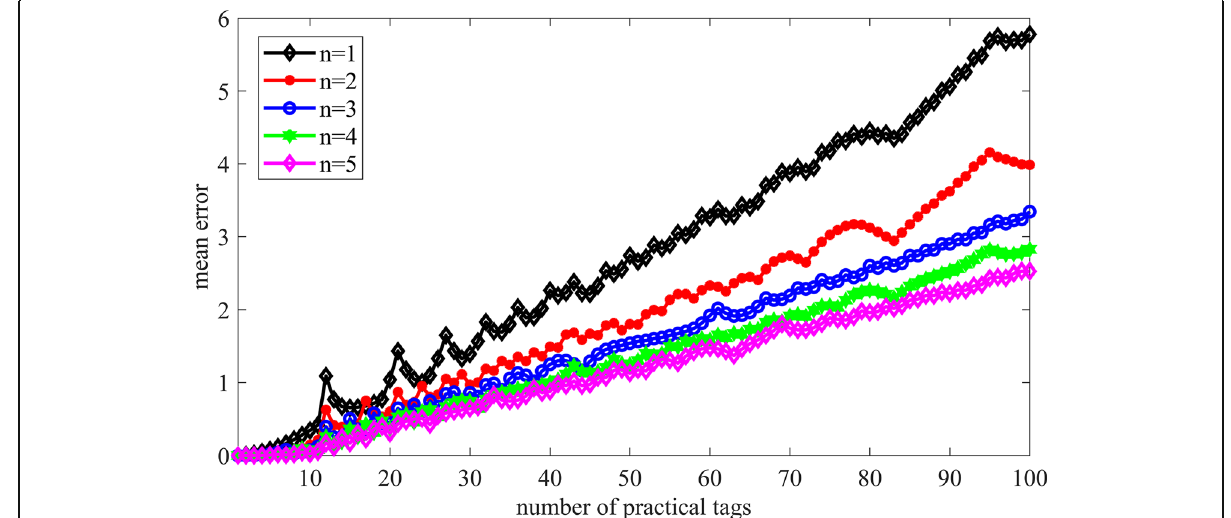
Fig. 6 Mean errors for different